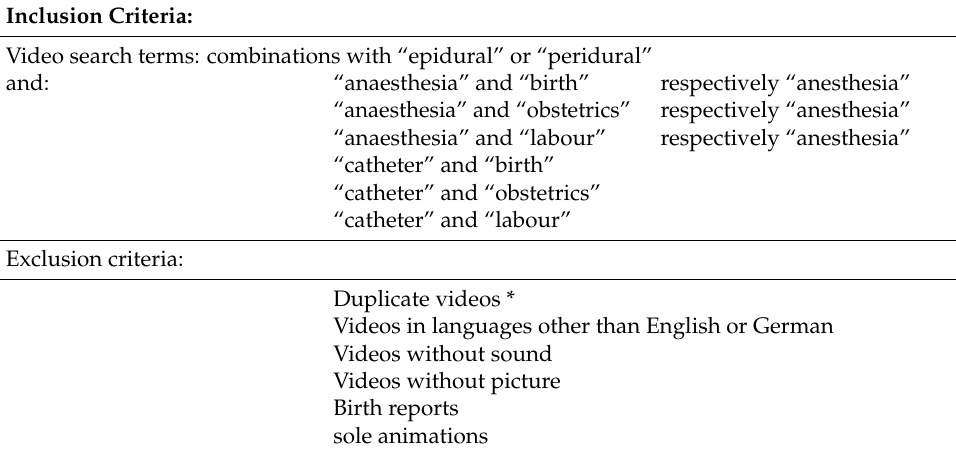
Table 1. Video Search: Inclusion and Exclusion